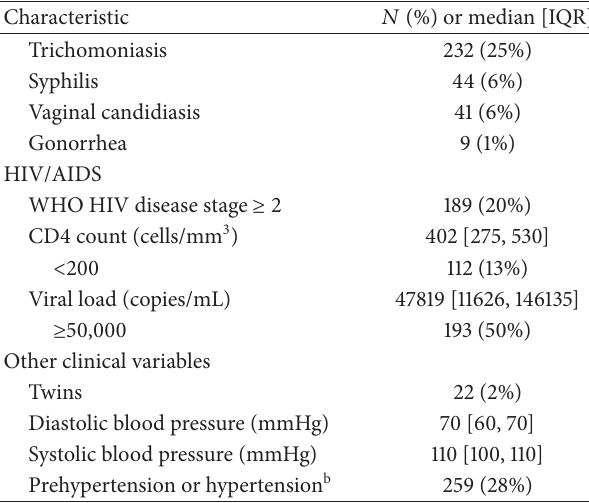
Table 1: Study population characteristics, 𝑁 = 927 a